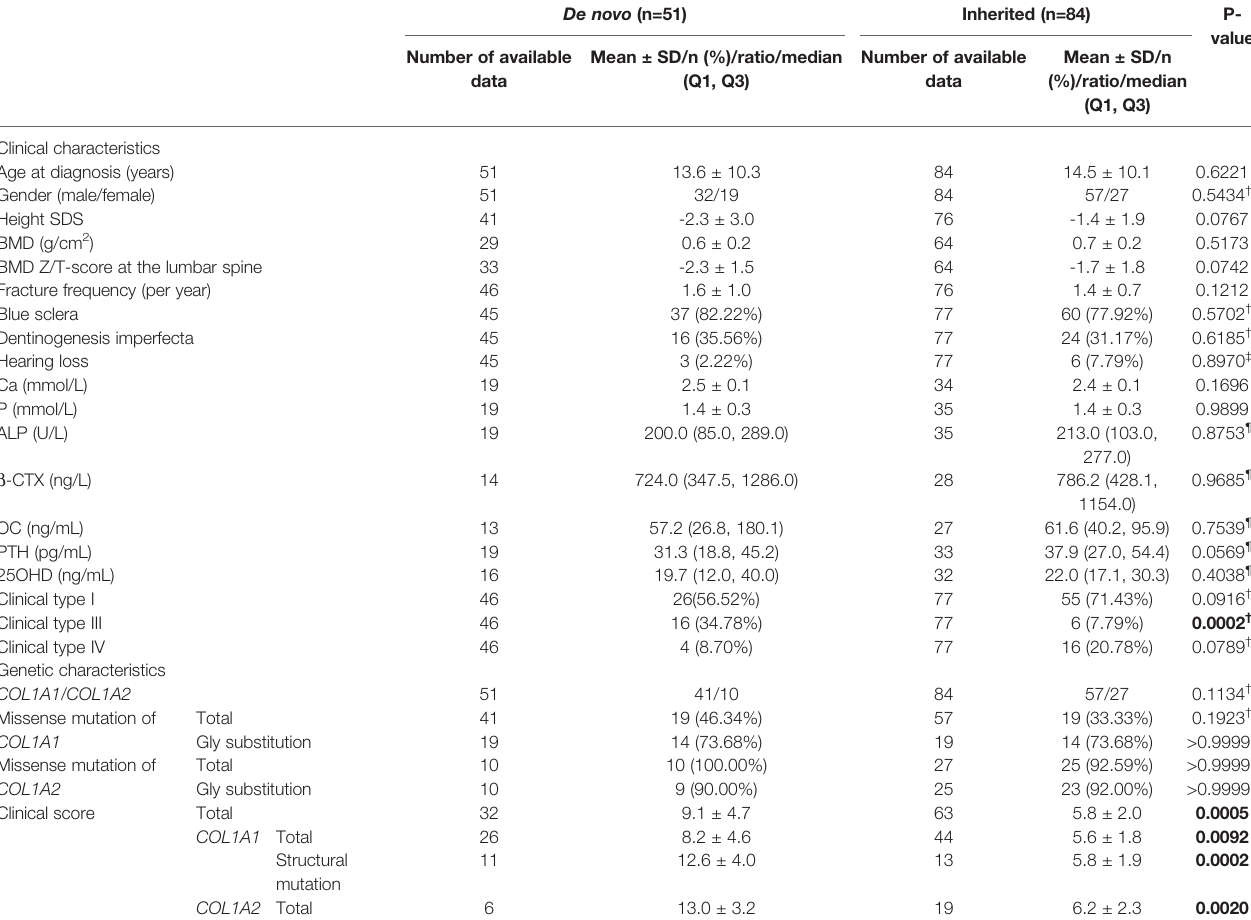
TABLE 2 | Clinical and genetic characteristics of de novo and inherited COL1A1/COL1A2 mutations of OI.